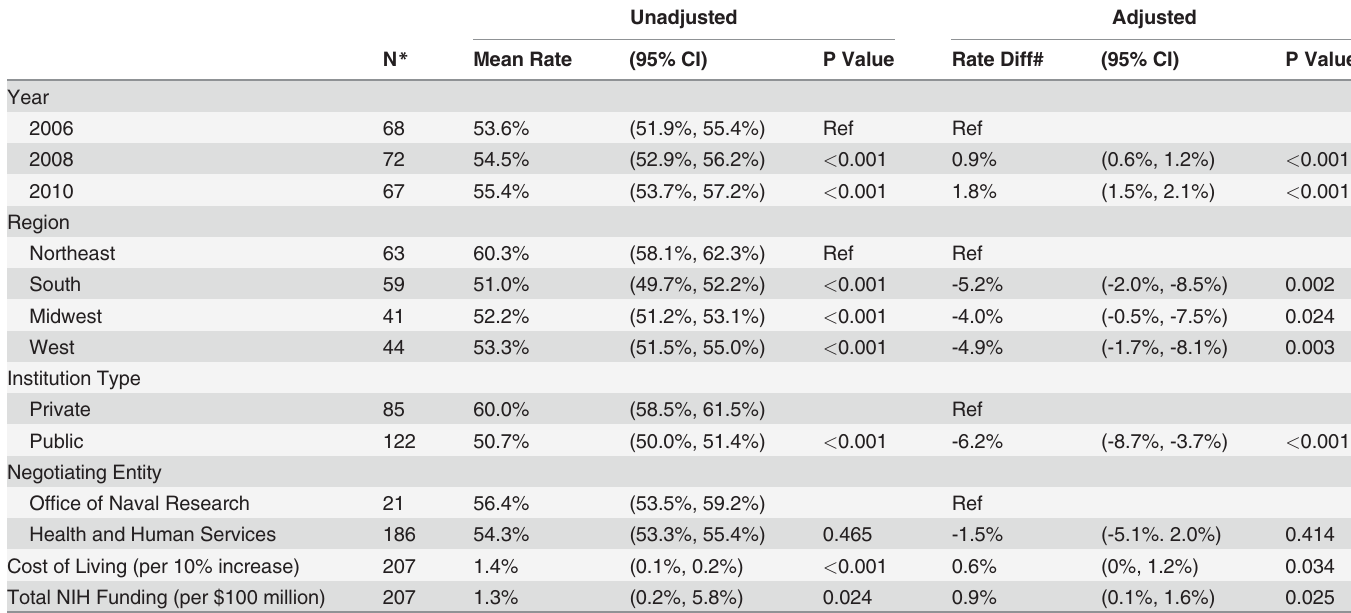
Table 1. Predictors of institutional indirect